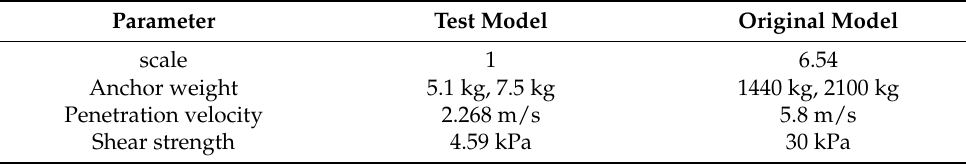
Table 9. Physical parameters of the test model and the original model. Parameter Table 10. The characteristics of the Kaolin clay. Characteristic